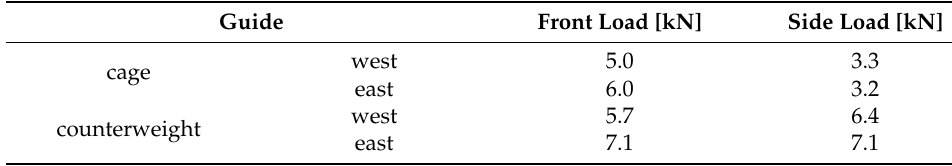
Table 1. Loads acting on the guides installed in Daniłowicz shaft.